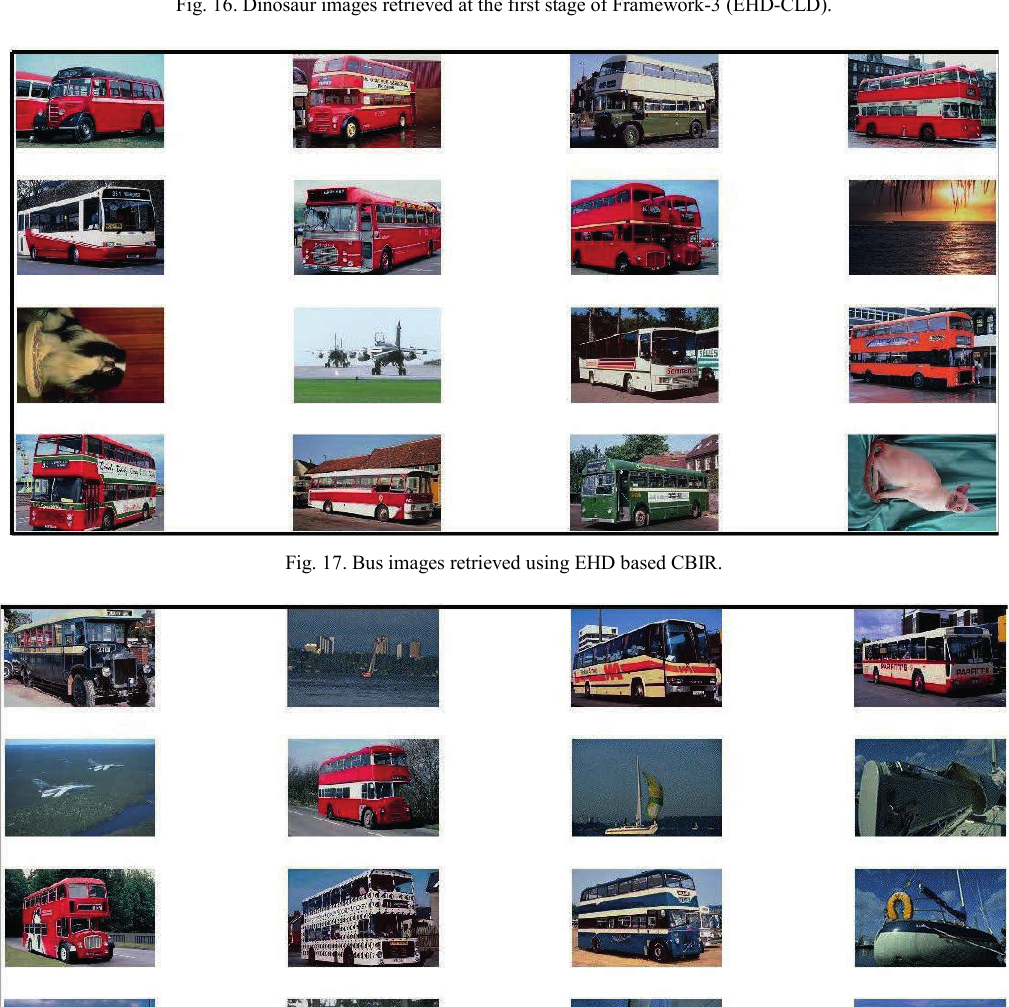
Fig. 16. Dinosaur images retrieved at the first stage of Framework-3 (EHD-CLD).